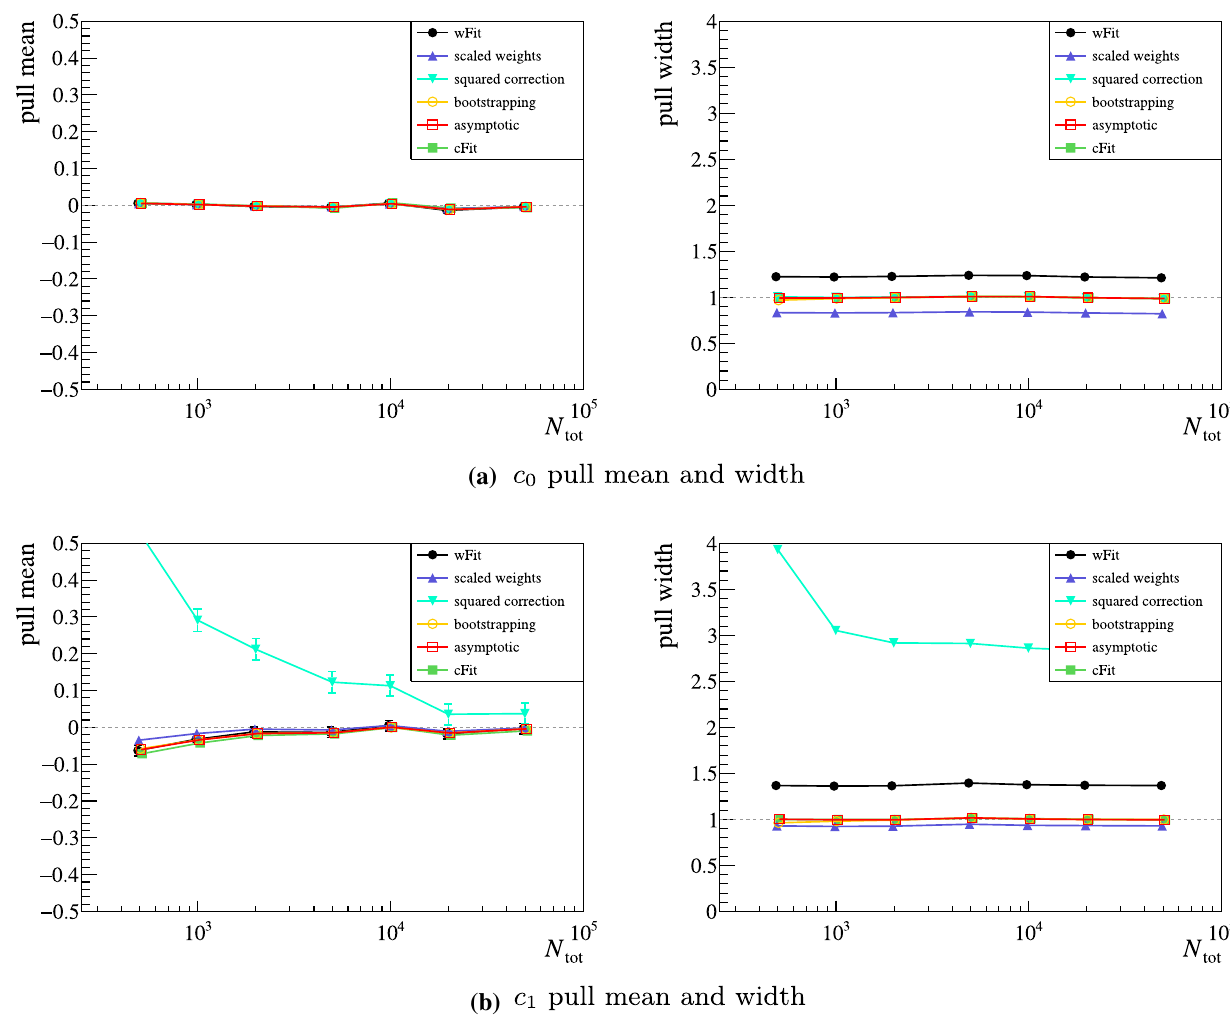
Fig. 5 (Left) Pull means and (right) pull widths for the efficiency correction (cid:4)( cos θ) = 0 . 3 + 0 . 7cos 2 θ , depending on total event yield N tot . The markers are slightly horizontally staggered to improve